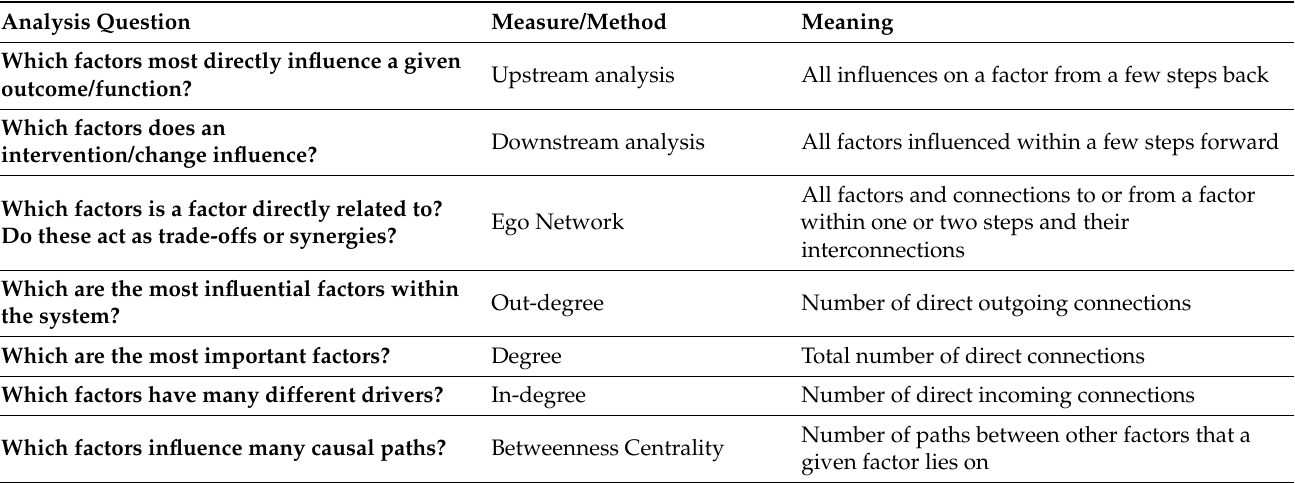
Table 1. PSM analysis questions and